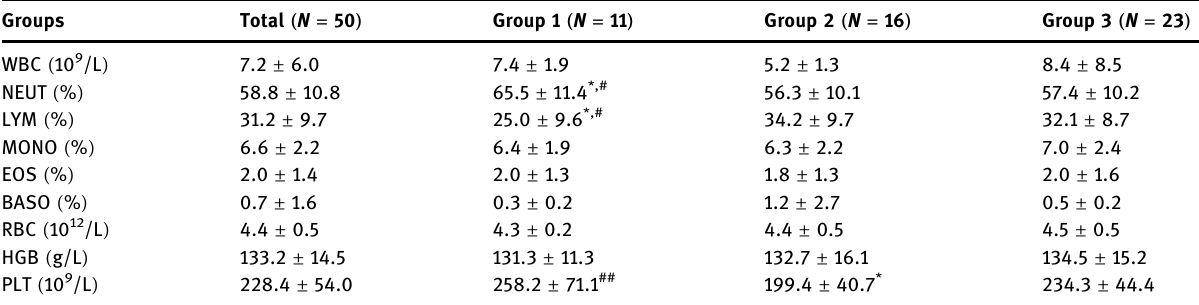
Table 2: Blood routine test results of the patients